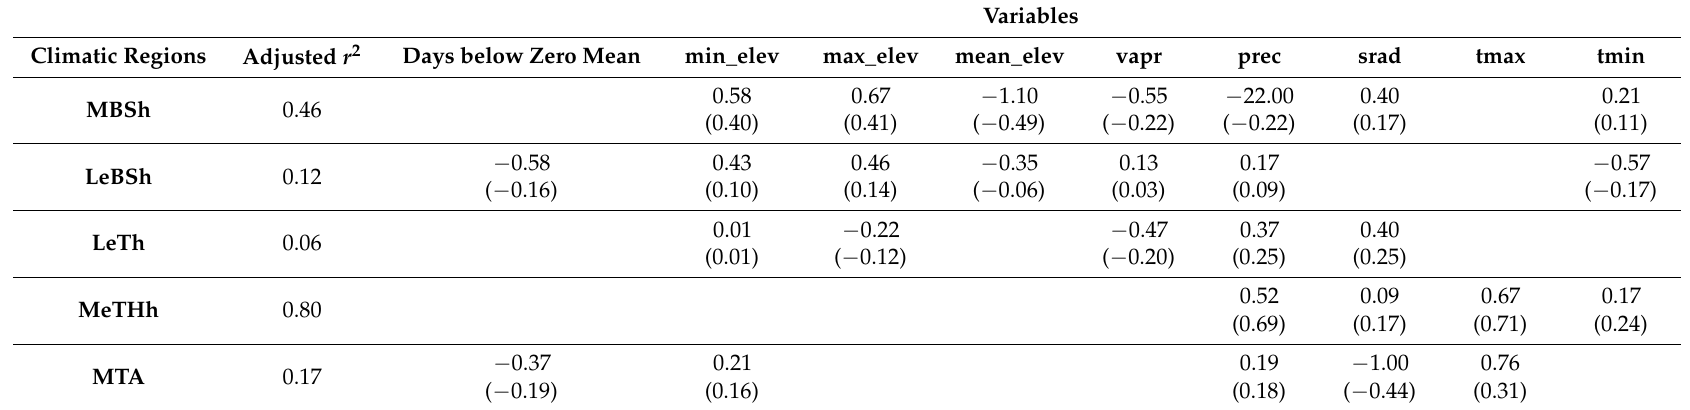
Table 3. AIC-based multiple regression analysis of the r 2 between observed and model-predicted flow in the environmental regions. Adjusted r 2 of the multiple regression, β coefficient, and partial correlations (in brackets) for the variables used in the multiple regression. β coefficients and partial correlations values marked in red are significant at p <